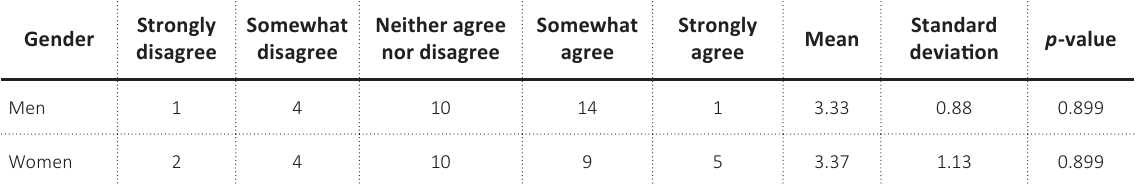
Table 5. I have the chance to do work that is well suited to my